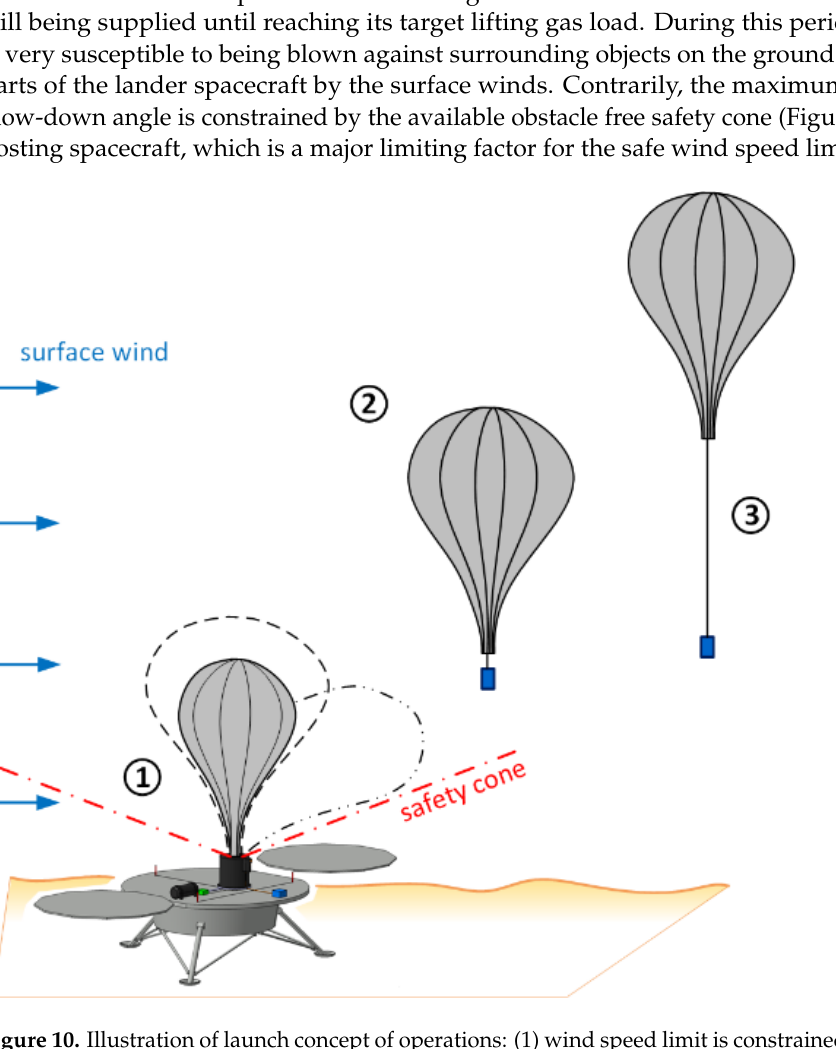
Figure 10. Illustration of launch concept of operations: (1) wind speed limit is constrained by obstacle-free cone around balloon support system, (2) release with retracted gondola, and (3) unreeling of suspension line when clear of ground.